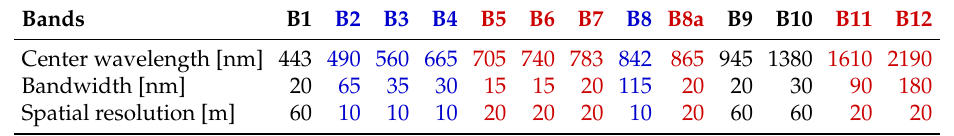
Table 1. Sentinel-2 bands. The 10 m bands are highlighted in blue. In red are the six 20 m bands to be super-resolved. The remaining are 60 m bands.